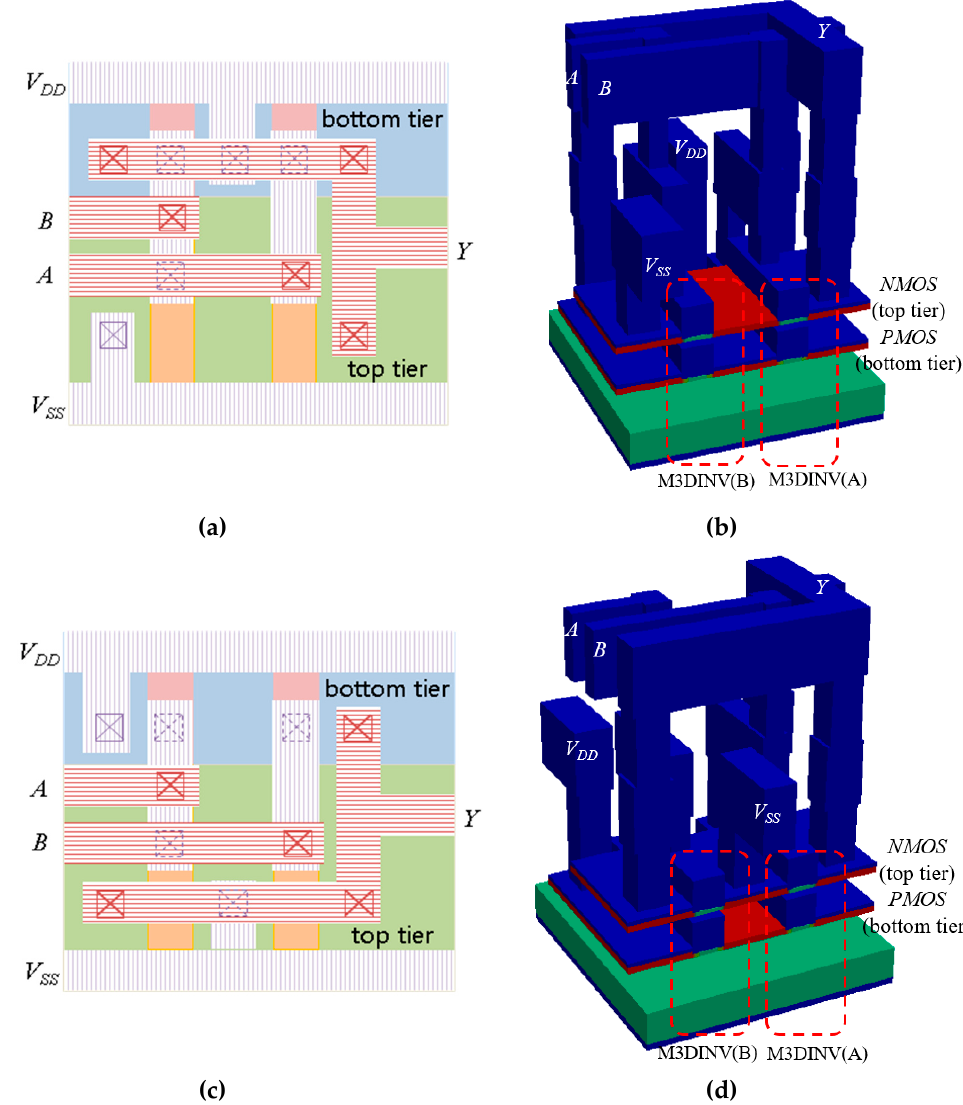
Figure 2. Two types of M3DI cell structure. ( a ) 2D layout of monolithic 3D NAND (M3DNAND), ( b ) 3D structure of M3DNAND, ( c ) 2D layout of M3DNOR, and ( d ) 3D structure of M3DNOR.